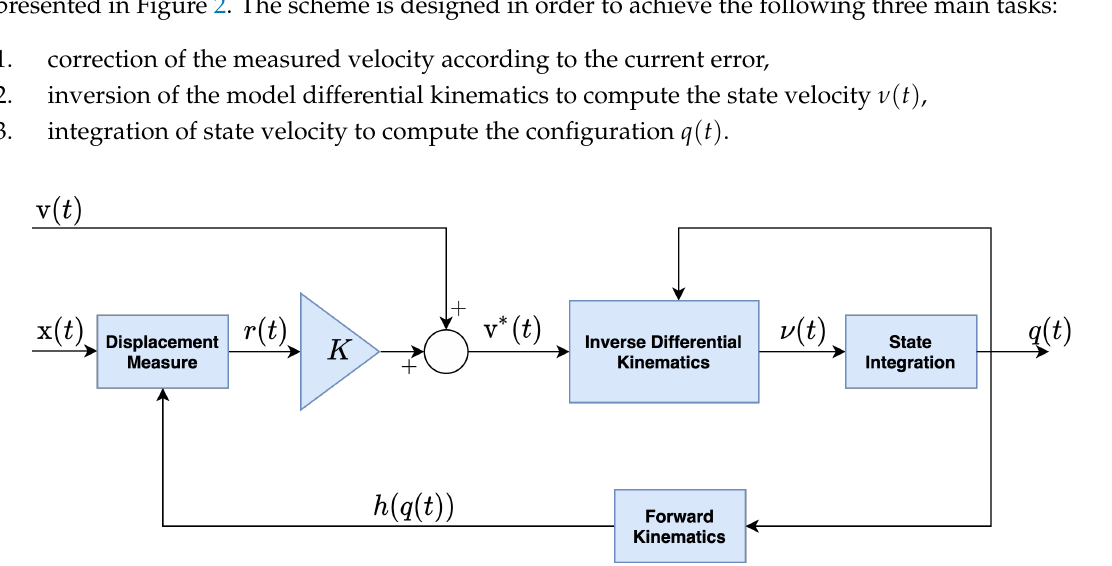
Figure 2. Dynamical optimization scheme for real-time inverse kinematics